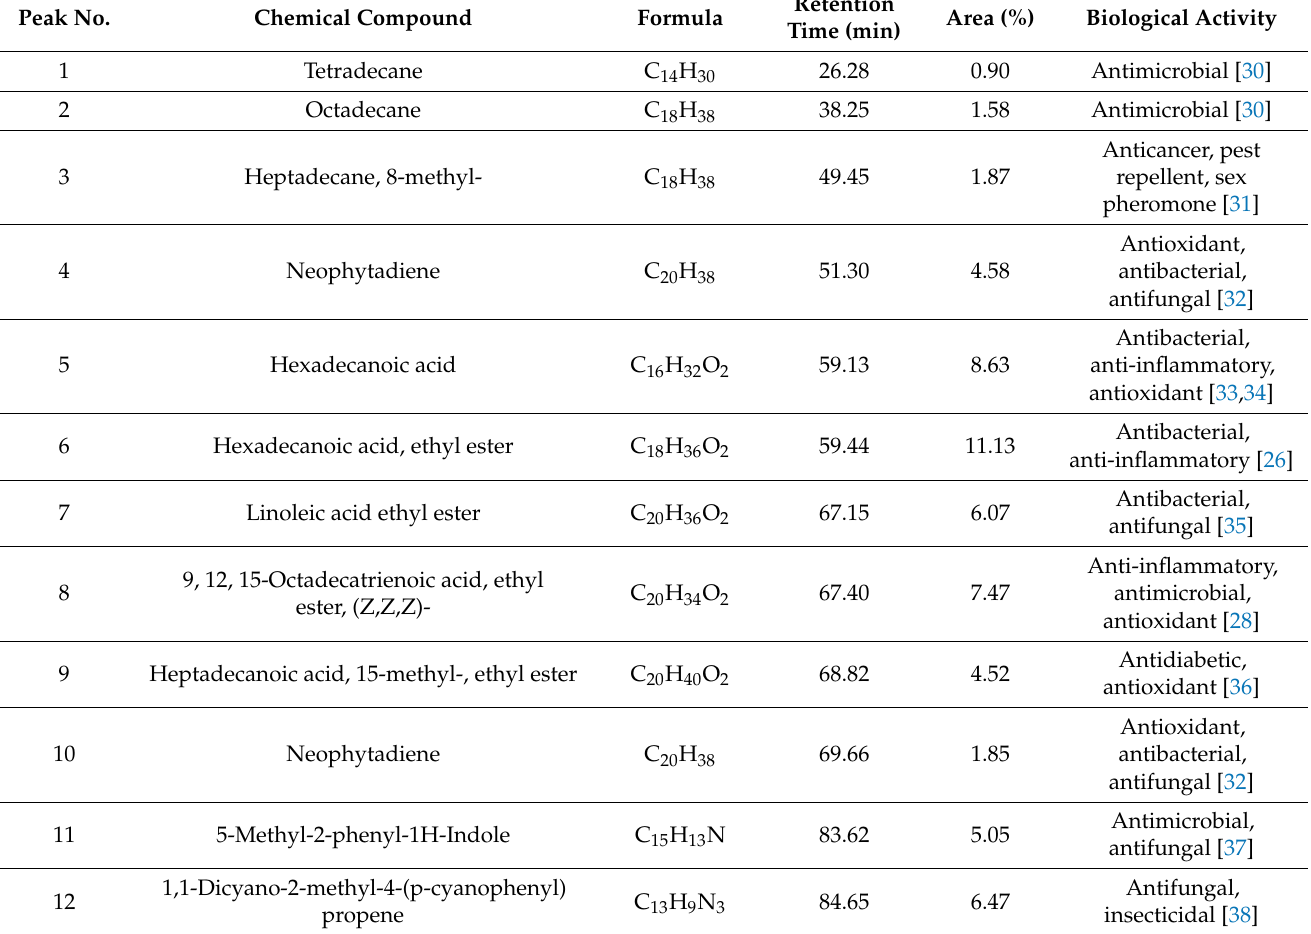
Table 2. Chemical composition of ethanolic extract of S. torvum